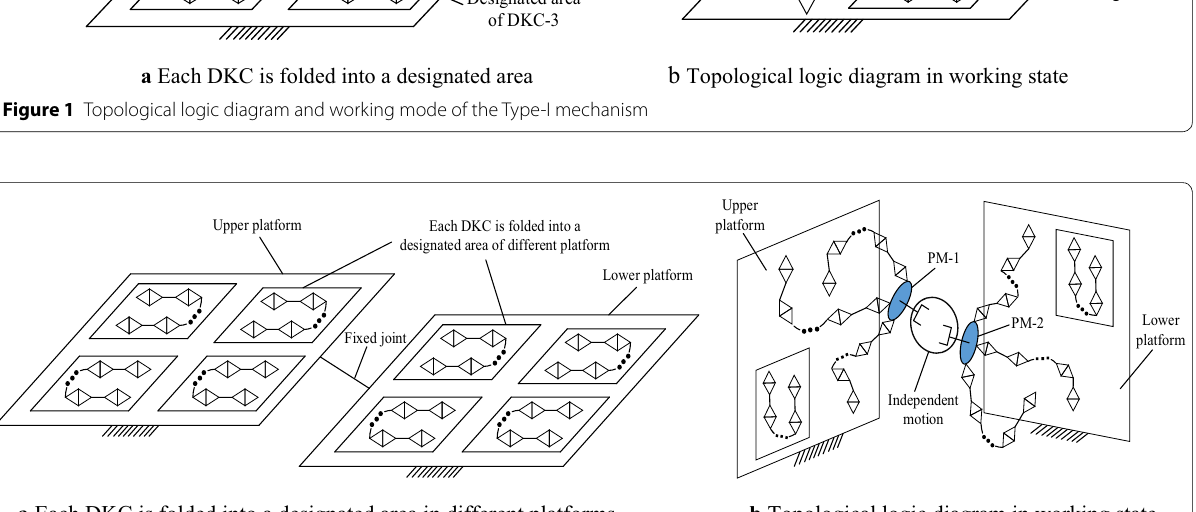
a Each DKC is folded into a designated area in different platforms Figure 2 Task topological logic diagram of the Type‑II